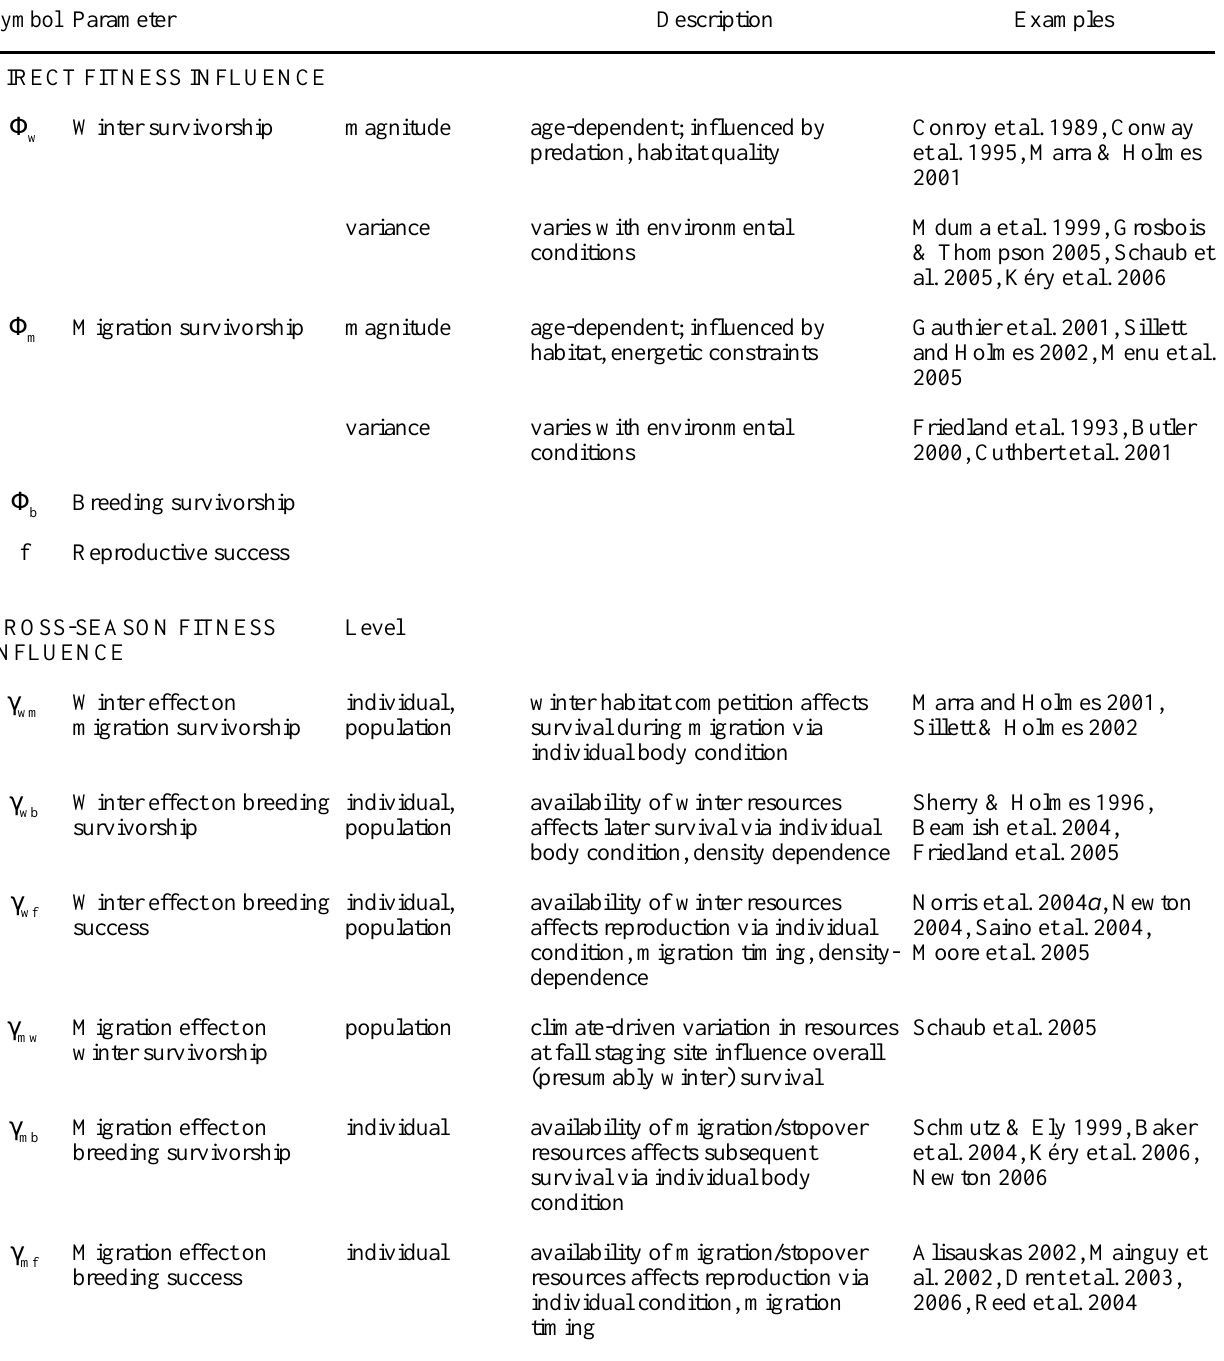
Table 2 . Conceptual links between seasonal habitats and population growth for seasonal migrants, as shown in Figure 2, with a description of each link and the level of cross-season interactions (see Figure 3). Note that “winter” refers to any primarily-stationary nonbreeding